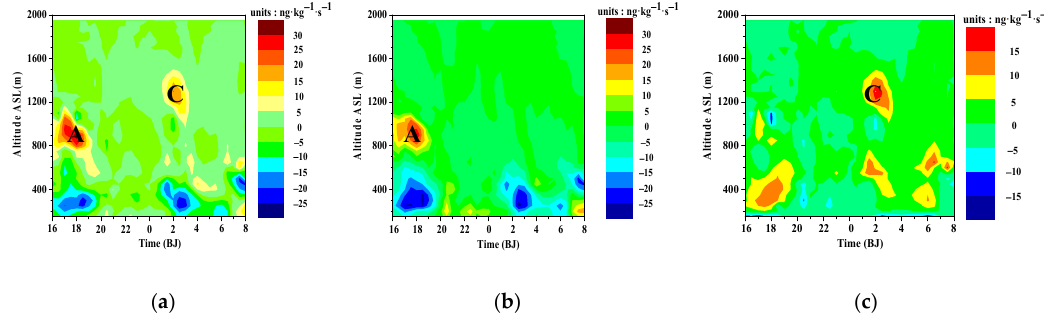
Figure 16. Time-altitude diagram of the simulated vertical advection transport rate and its components over Daqing from the evening of 24 October to the morning of 25 October. ( a ) Vertical advection transport rate; ( b ) BC concentration term; ( c ) Vertical gradient term of BC